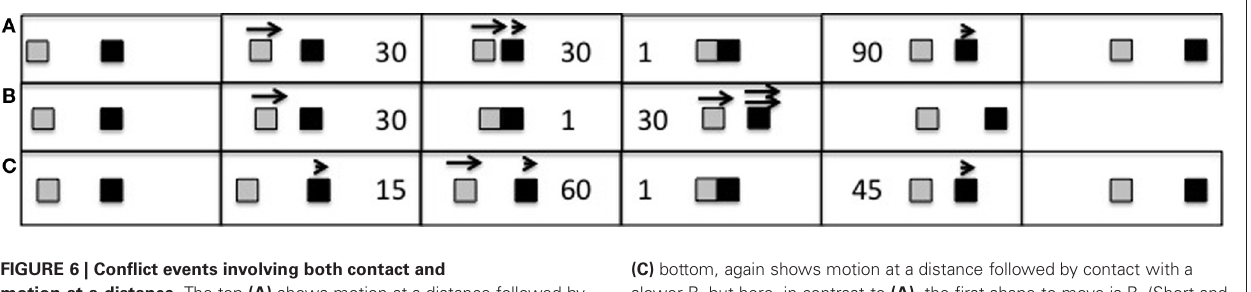
FIGURE 6 | Conflict events involving both contact and motion-at-a-distance. The top (A) shows motion at a distance followed by contact when A catches up with a slower B. (B) middle shows contact followed by motion at increasing distance due to B moving at double speed.